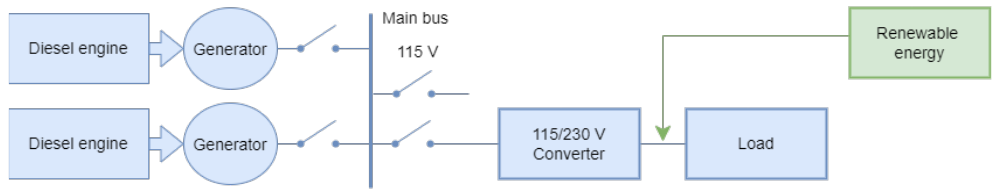
Figure 2. Schematic diagram of power distribution to implement.